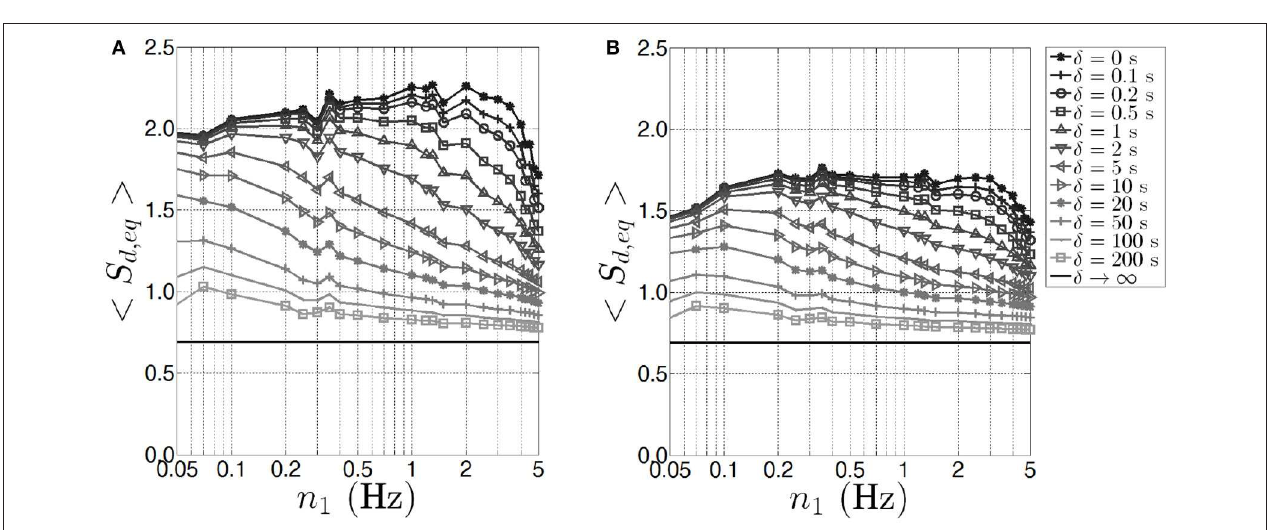
FIGURE 11 | Equivalent response spectrum: (A) x = 0.002; (B) x = 0.01. Reproduced from Solari and De Gaetano (2018) with permission from